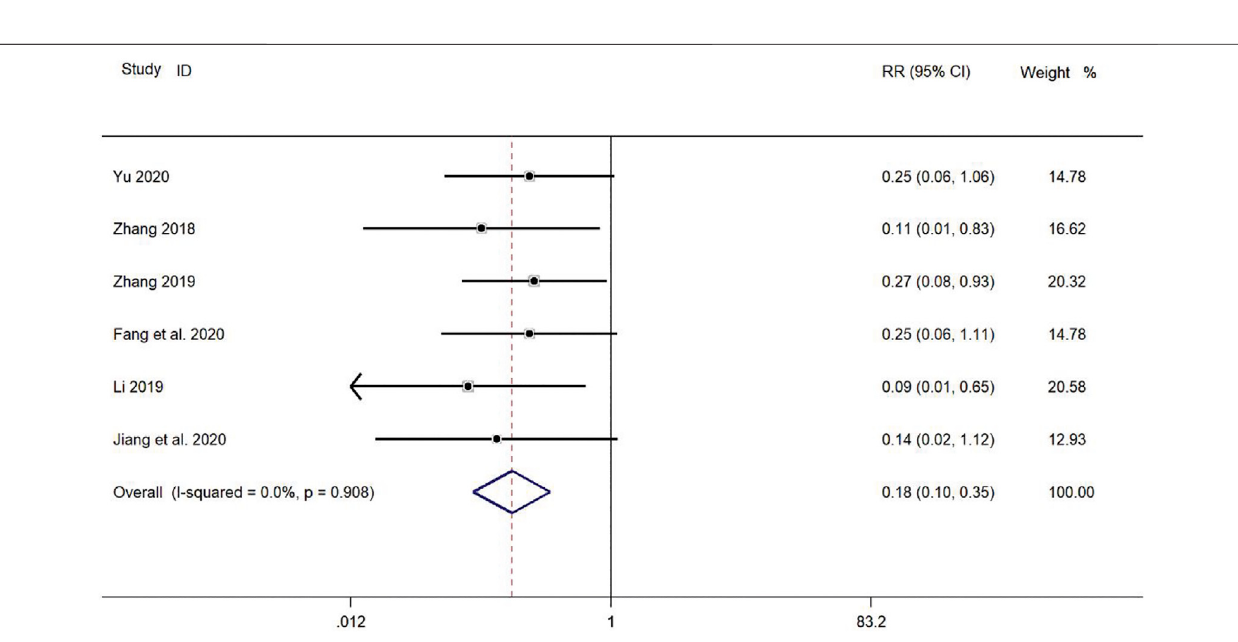
Frontiers in Pharmacology |